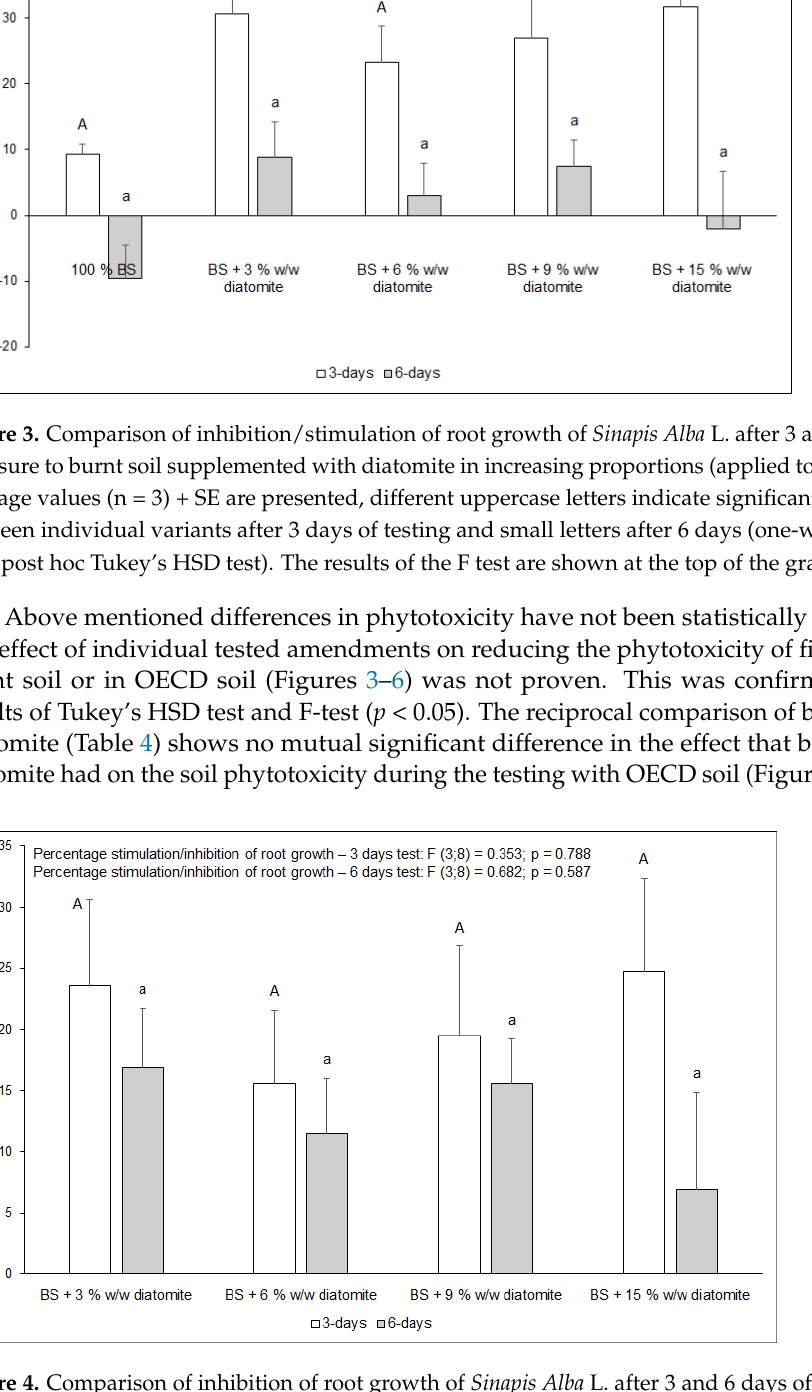
Figure 4. Comparison of inhibition of root growth of Sinapis Alba L. after 3 and 6 days of exposure to burnt soil supplemented with diatomite in increasing proportions (compared to burnt soil). Average values (n = 3) + SE are presented, different uppercase letters indicate significant differences between individual variants after 3 days of testing and small letters after 6 days (one-way ANOVA with post hoc Tukey (cid:48) s HSD test). The results of the F test are shown at the top of the